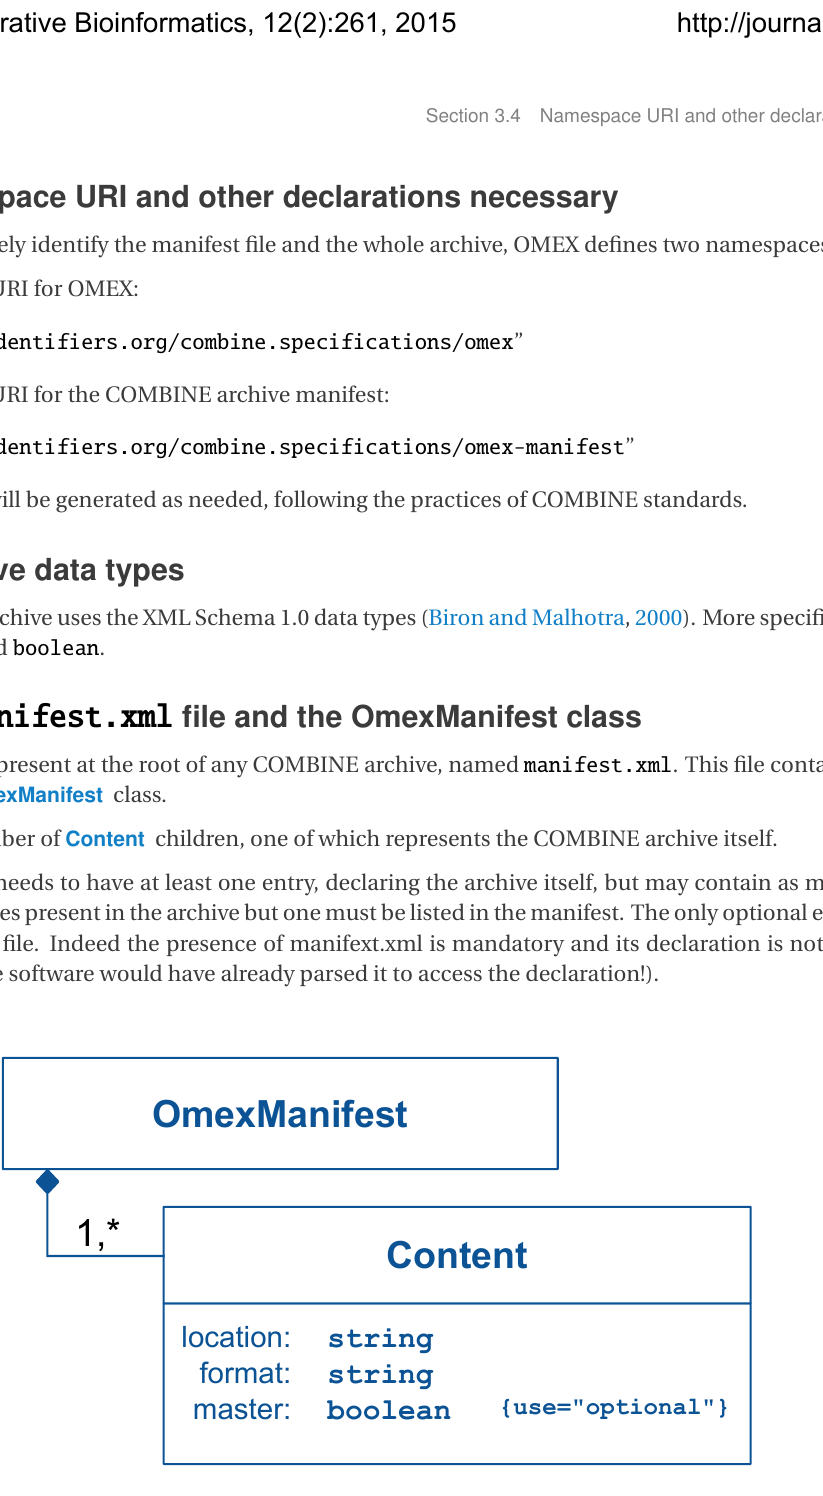
Figure 1: A UML representation of the Manifest. Each manifest contains a number of Content